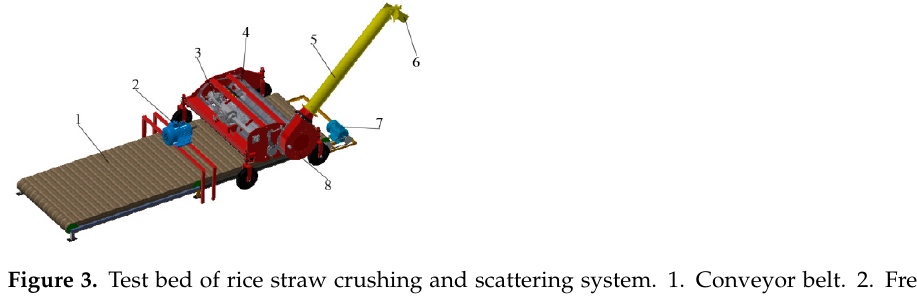
conversion motor. 3. Grinding knife shaft. 4. Screw conveyor. 5. Throwing channel. 6. Blade scattering device. 7. Frequency conversion auxiliary motor. 8. Throwing blower.